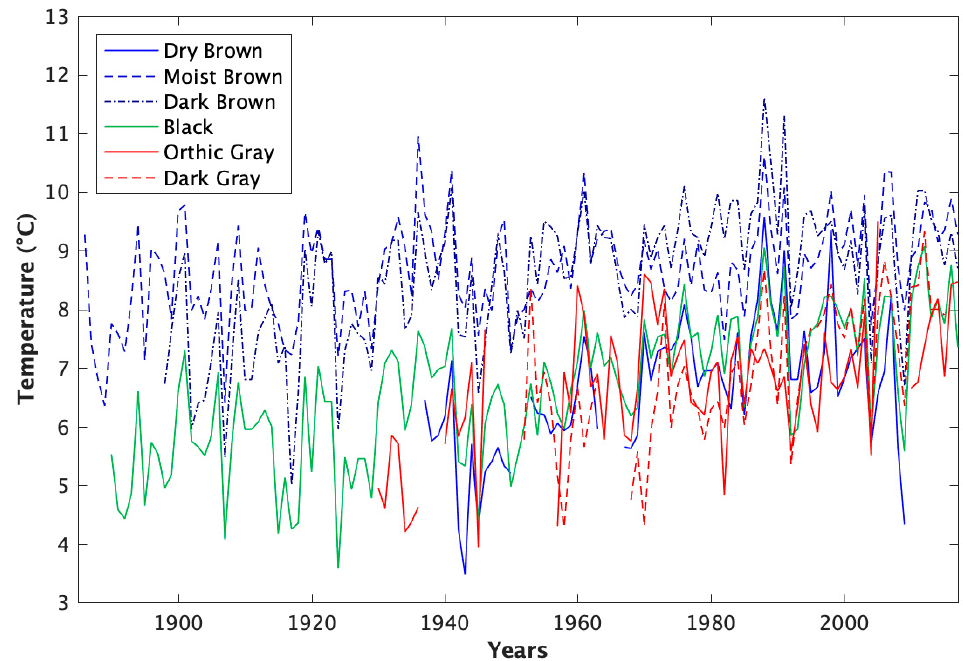
Figure 5. Growing season (May–August) minimum temperature (°C) (1885–2016) for all soil zones.